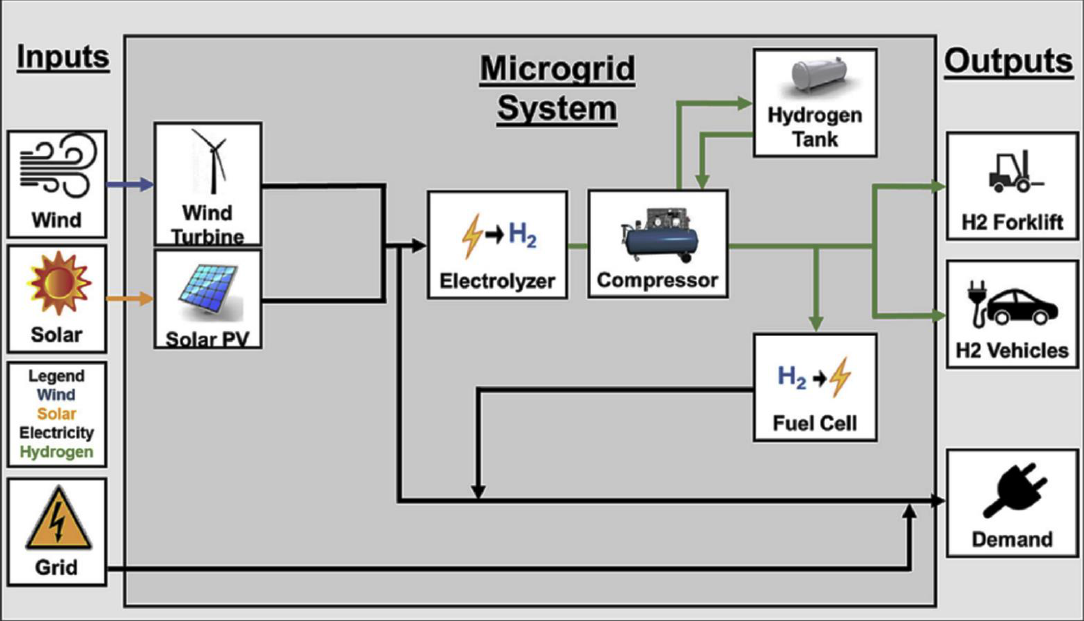
Figure 8. Schematic representation of a community microgrid system modeled in GAMS. Reprinted with permission from Ref. [25]. 2017, Elsevier. Table 1. Modeling and optimization methods for hybrid PV-RHFC microgrid systems.